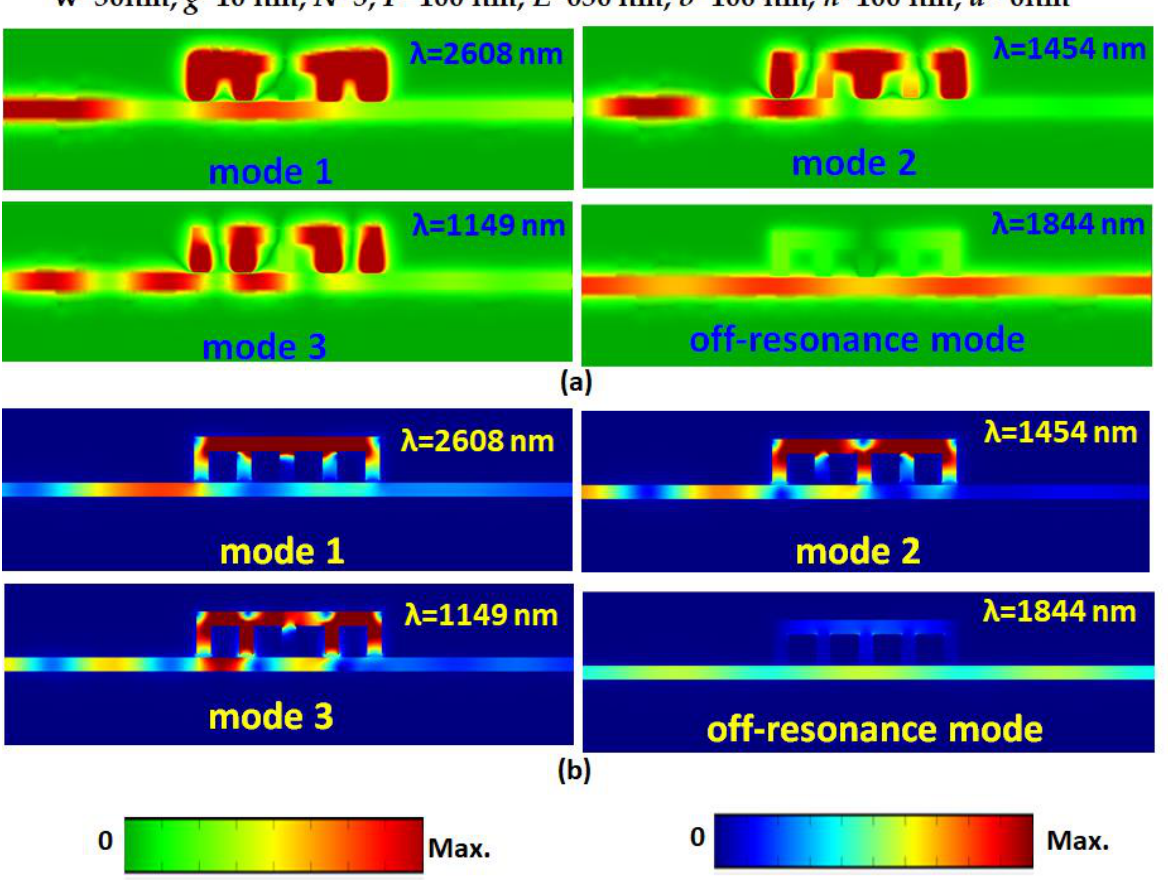
Figure 3. Normalized ( a ) magnetic field intensity and ( b ) electric field intensity at the corresponding resonance modes and one of the off-resonance modes.